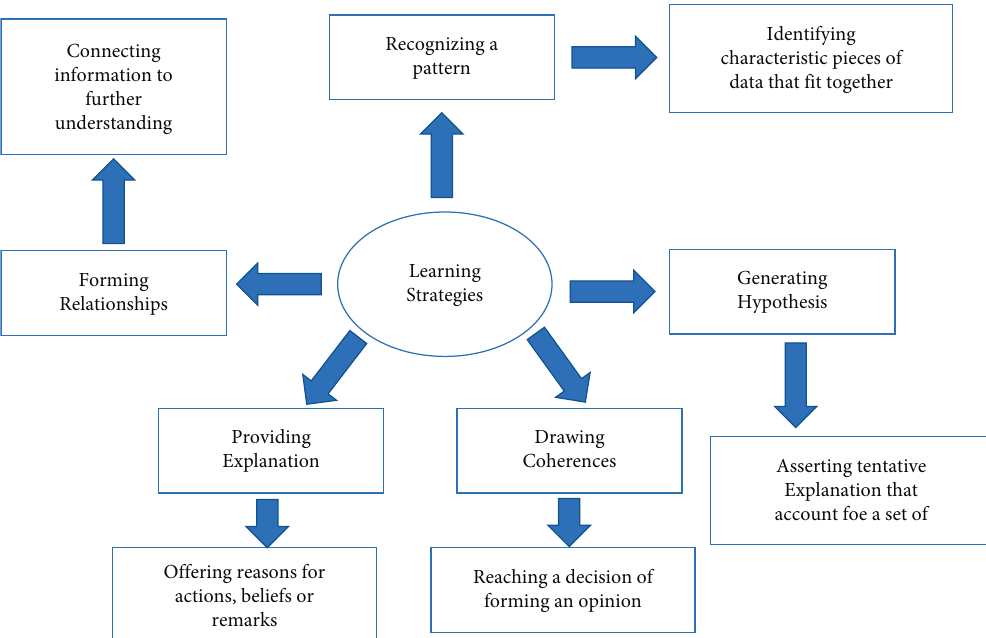
Figure 2: Learning